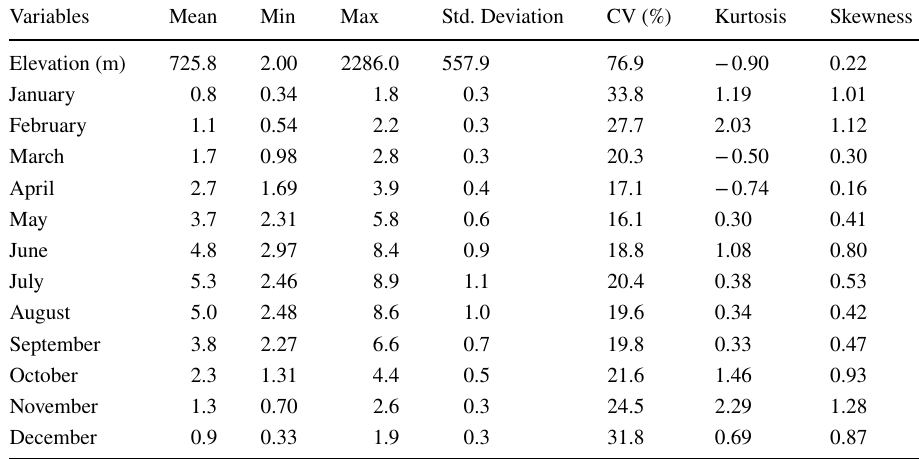
Fig. 5 a Violin plots of the model predictions, b Taylor diagram for the SVR7, KNN7, and MGGP7 models Table 5 Descriptive statistics for ET 0 (mm day −1 ) for months